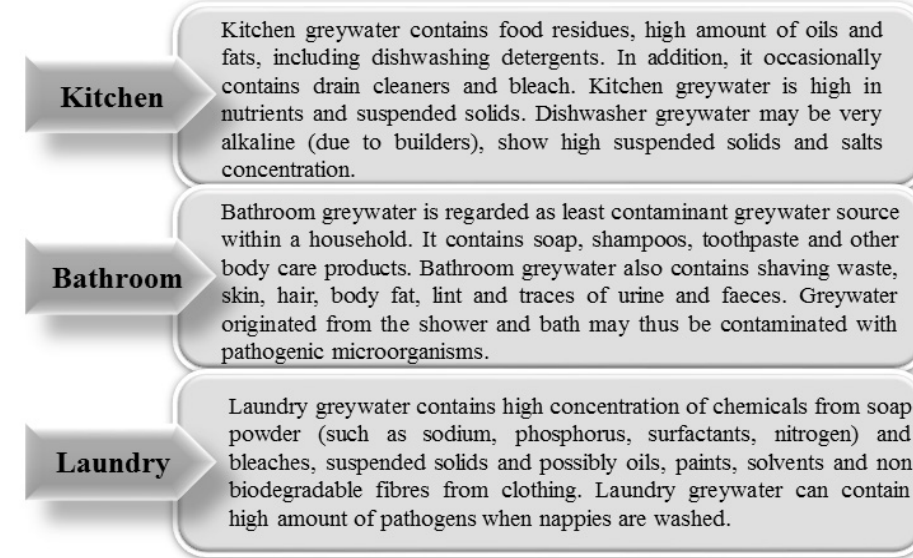
Figure 1. Characteristics of greywater.